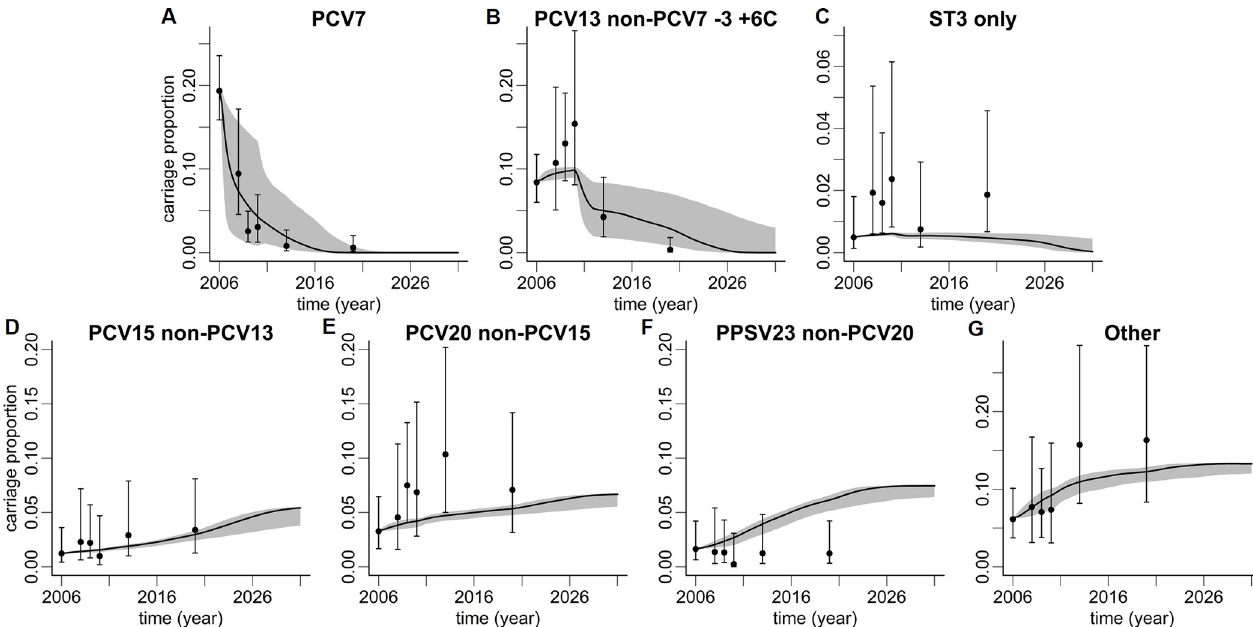
Fig 4. Predictions of vaccination model for children aged < 2y. Shown are vaccine serotype groups (upper row) PCV7 (A), PCV13 non-PCV7–3 +6C (B), serotype 3 (C), and non-vaccine serotype groups (lower row) PCV15 non-PCV13 (D), PCV20 non-PCV15 (E), PPSV23 non-PCV20 (F), and Other (G). Data points (pneumococcal carriage proportions regarding all individuals of the age group in Germany, including non-carriers) are shown as filled circles with 95% CIs. Data points were calculated from adjusted IPD incidence rates via case-carrier ratios. Simulation results are depicted by lines with shaded 95% prediction intervals. The wide shades observed for PCV7 and PCV13 non-PCV7–3 +6C are caused by uncertainty of direct vaccination effects while the variability observed in non-vaccine serotype groups is indirect. Thus, respective prediction intervals are narrower.